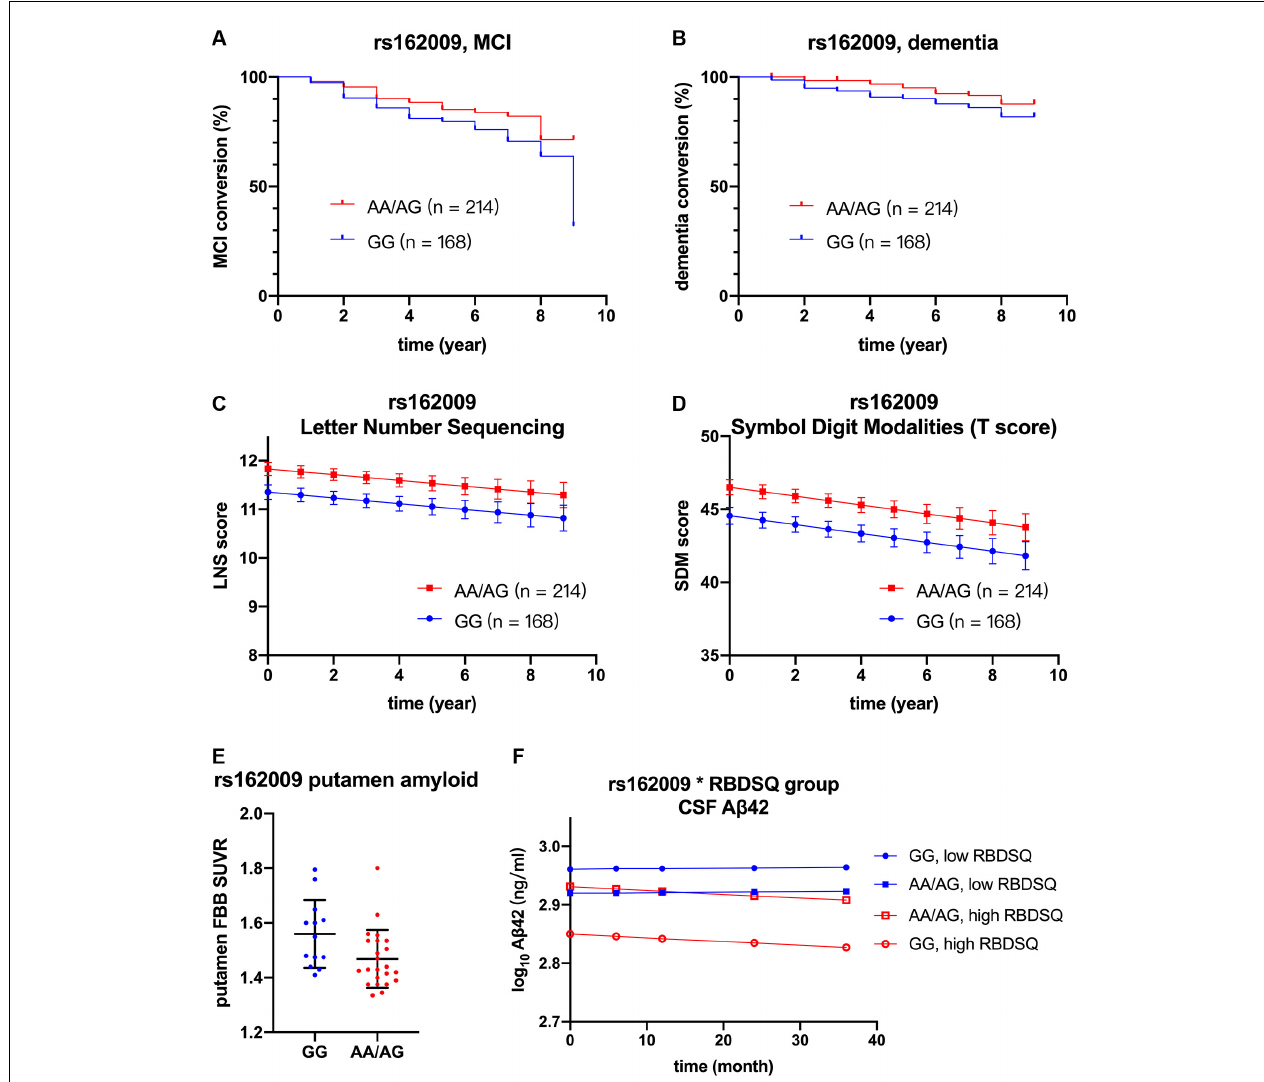
FIGURE 3 | Association between rs162009, cognition, and biomarkers. rs162009 (AA/AG vs. GG) had slower conversion to MCI (HR = 0.646, 95% CI = 0.409–1.019, p = 0.060) (A) and dementia (HR = 0.473, 95% CI = 0.234–0.957, p = 0.037) (B) , better performance in letter-number sequencing ( β = 0.477, SE = 0.183, p = 0.009) (C) , and symbol digit modalities test ( β = 2.401, SE = 1.953, p = 0.006) (D) . rs162009 AA/AG genotype also had lower putamen FBB SUVRs ( β = − 0.105, SE = 0.039, p = 0.012) (E) . In the subgroup of patients with high RBDSQ score (averaged score during the first 3 year ≥ 5.5, N = 117), patients with rs162009 AA/AG genotype had higher CSF A β 42 levels ( β = 0.081, SE = 0.033, p = 0.017), indicating its protective effect on A β deposition (F) . Covariates for cox regression and linear mixed model included age, sex, APOE ε 4 carriage, years of education, and baseline MoCA score. Lines in Panels (C,D,F) represent the estimated marginal mean from the mixed model. FBB, 18 F Florbetaben; MCI, mild cognitive impairment; RBDSQ, Rapid Eye Movement Sleep Behavior Disorder Screening Questionnaire; SUVRs, standard uptake value